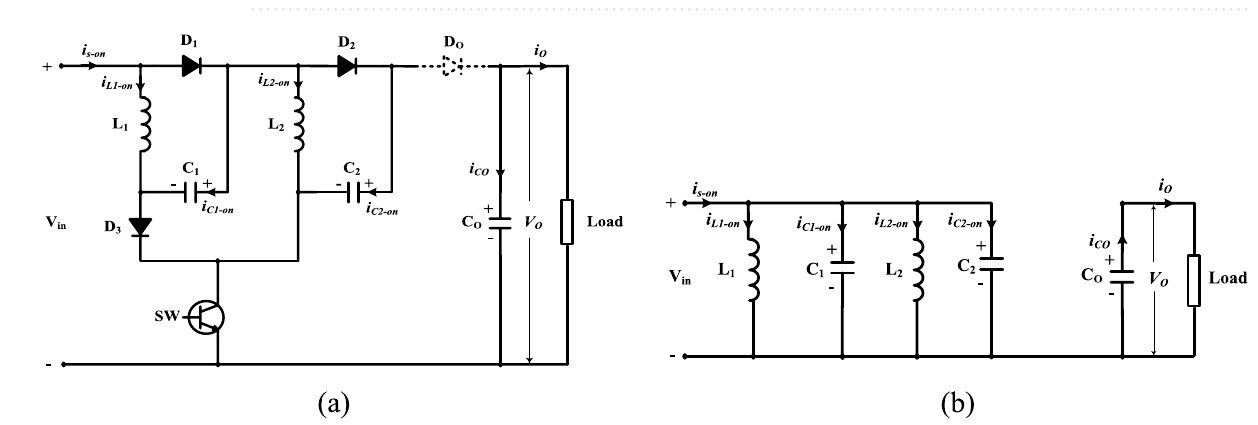
Figure 4. Equivalent circuit of Mode 1: ( a ) active and inactive elements, and ( b ) equivalent electrical